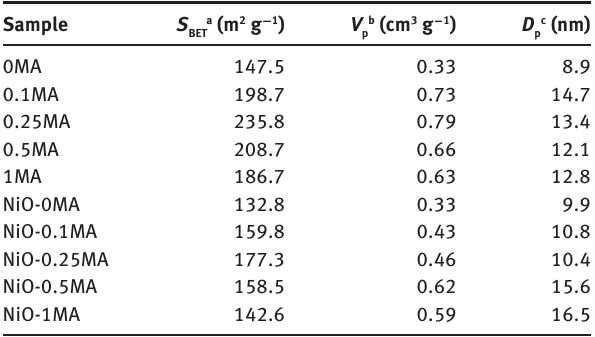
Table 1: Physical parameters of the supports and oxidized catalysts.